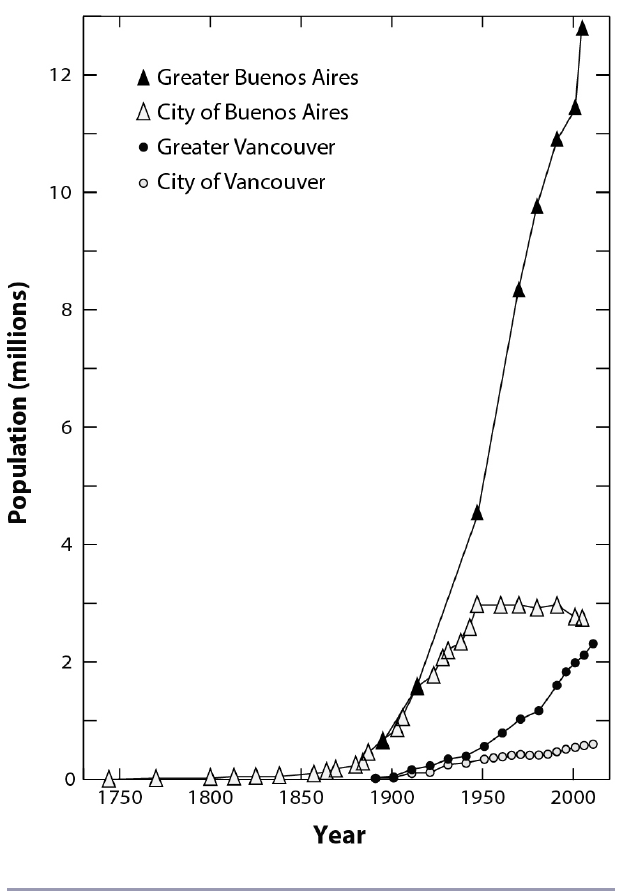
Fig. 2. Population growth over time in the City of Buenos Aires and Gran Buenos Aires (left) and the City of Vancouver and Metro Vancouver